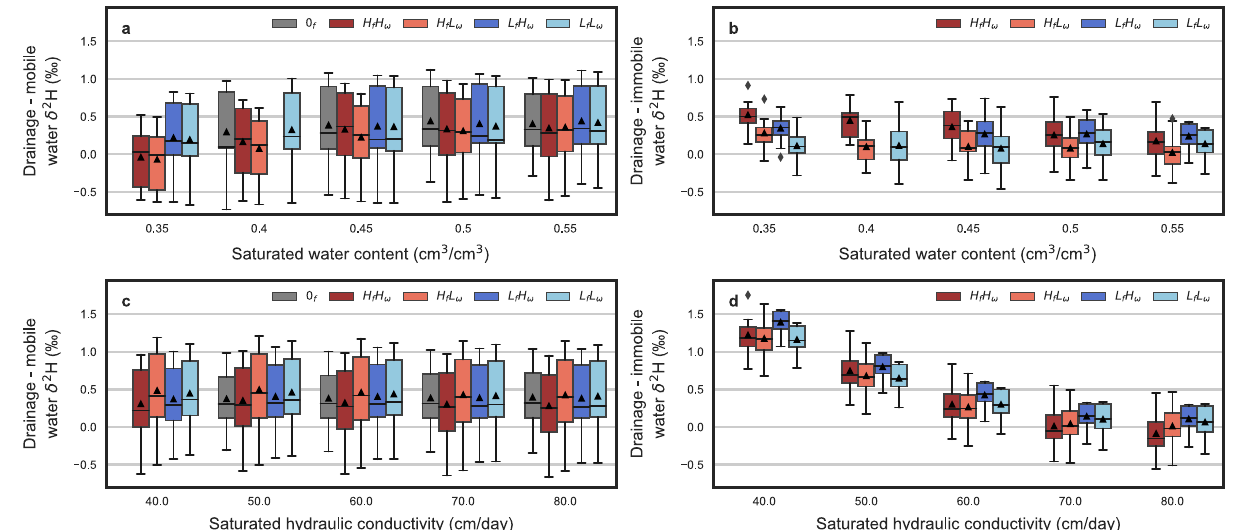
Fig. 3 | The in fl uence of soil hydraulic parameters on isotope separation. The effect across model simulations of varying soil saturated water content on the average δ 2 H difference between drainage and a mobile or b immobile soil water as well as the in fl uence of varying soil saturated hydraulic conductivity on the average δ 2 H difference between drainage and c mobile or d immobile soil water. Differences are show as boxplots for models with high and low immobile frac- tions ( H f and L f ) and transfer rates ( H ω and L ω ) as well as for a single porosity